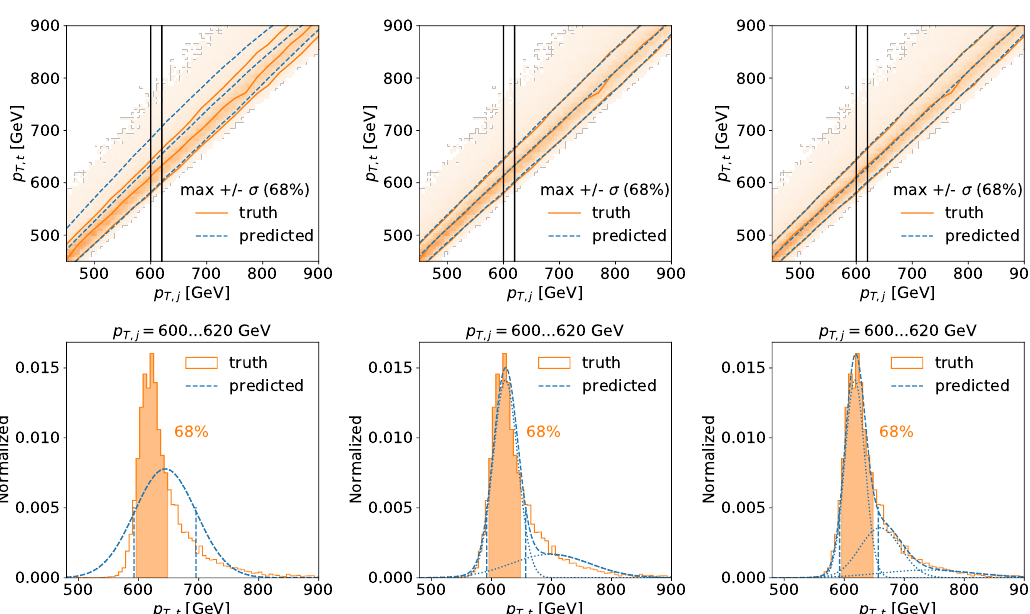
Figure 8: Upper: 2-dimensional distribution of p truth around the maximum. In blue we show the BNN results. Lower: p truth for a narrow slice in p three